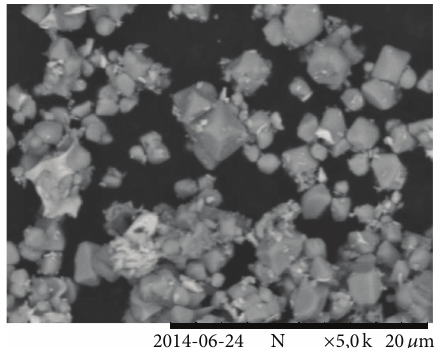
Figure 7: SEM micrograph of pulverized MOV after leaching in pH 1 sulfuric acid solution for 240 minutes. The Sb-rich phase remains along with some undissolved Bi-rich phase.